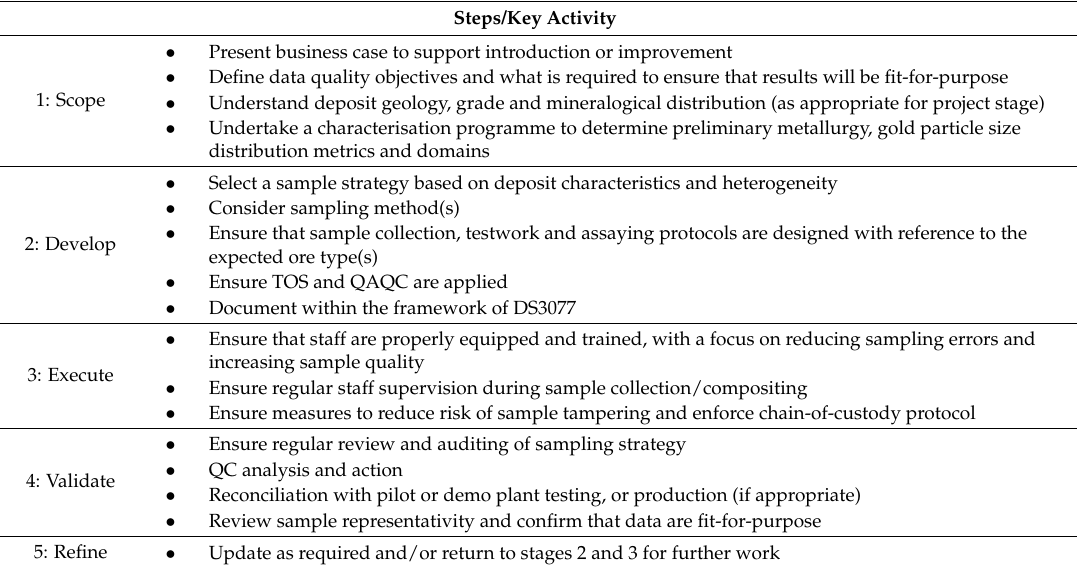
Table 28. Summary of steps to achieve optimal metallurgical sampling programmes (modified from